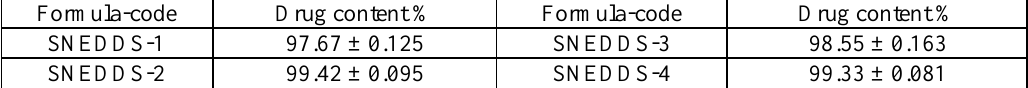
Table 8. The drug content percent of a bromocriptine mesylate liquid self-nano emulsifying drug delivery system (mean ±SD) n=3.